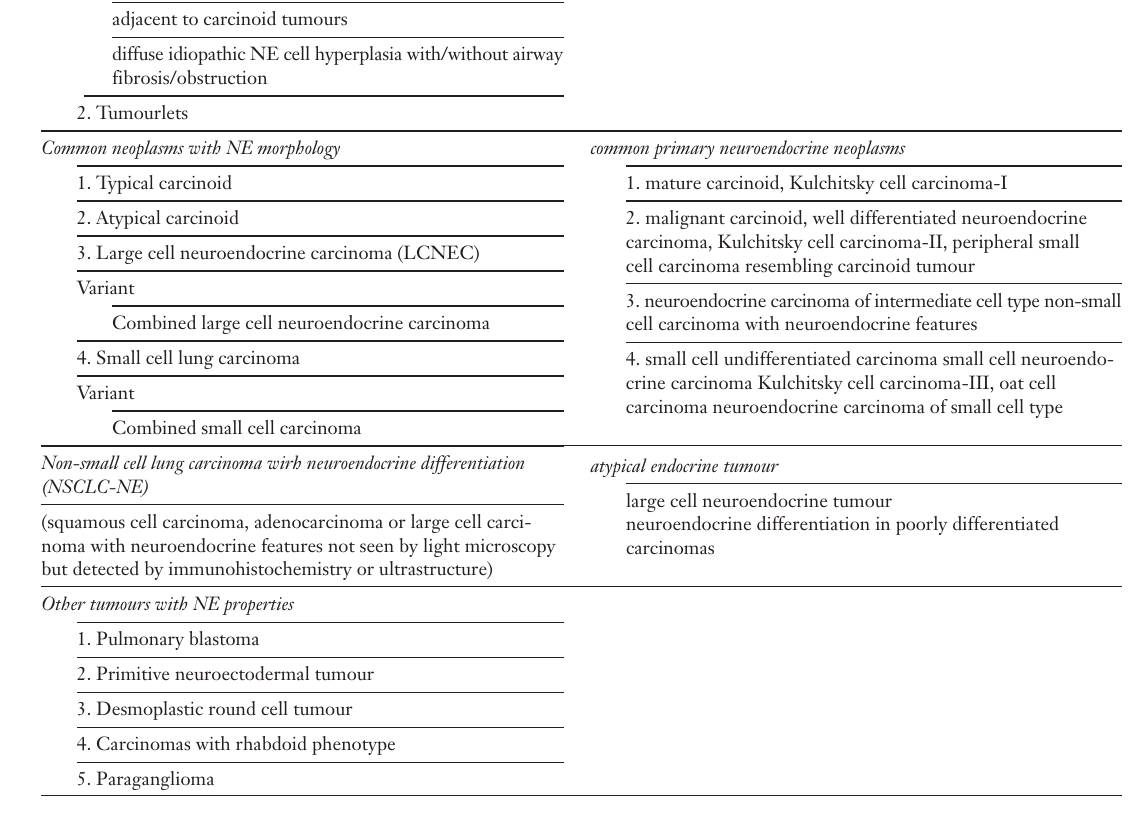
Diagnostic criteria for neuroendocrine